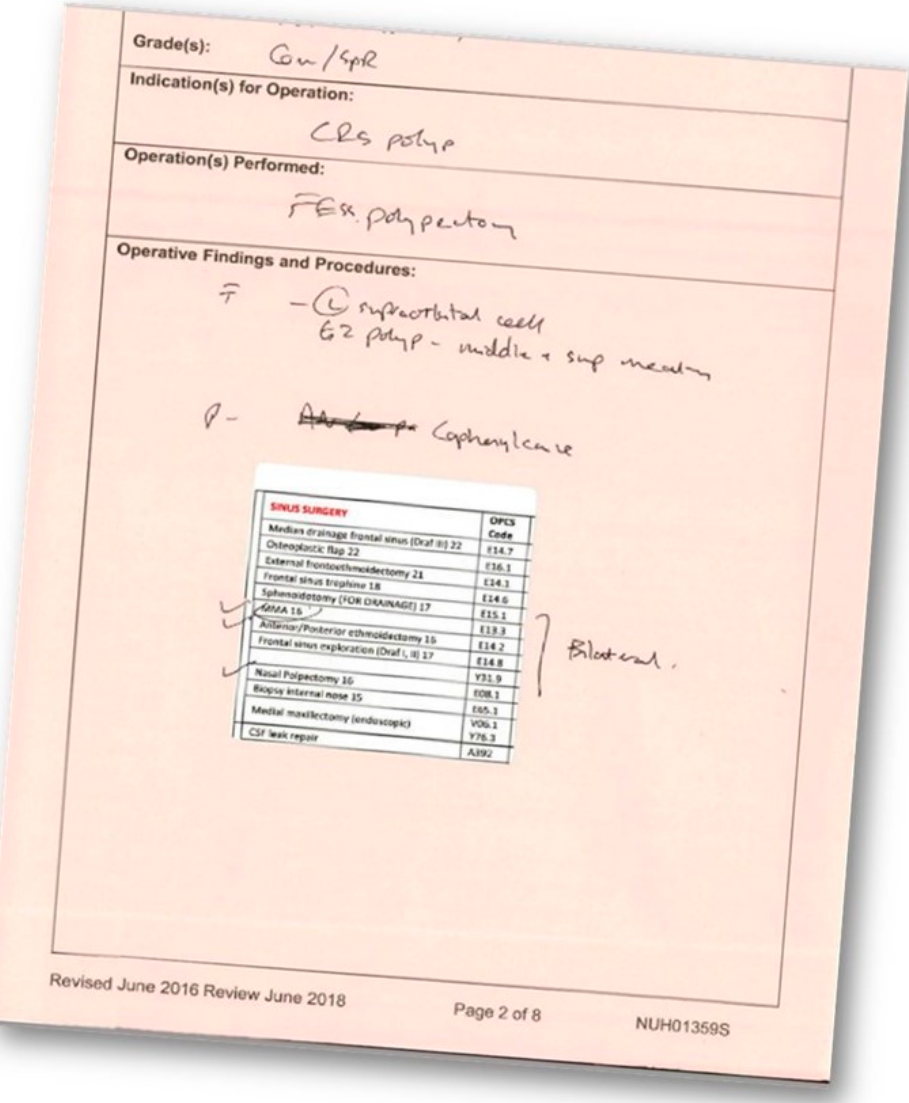
Figure 1. An example of an operation note using the first edition of the intraoperative coding sticker (ICS).